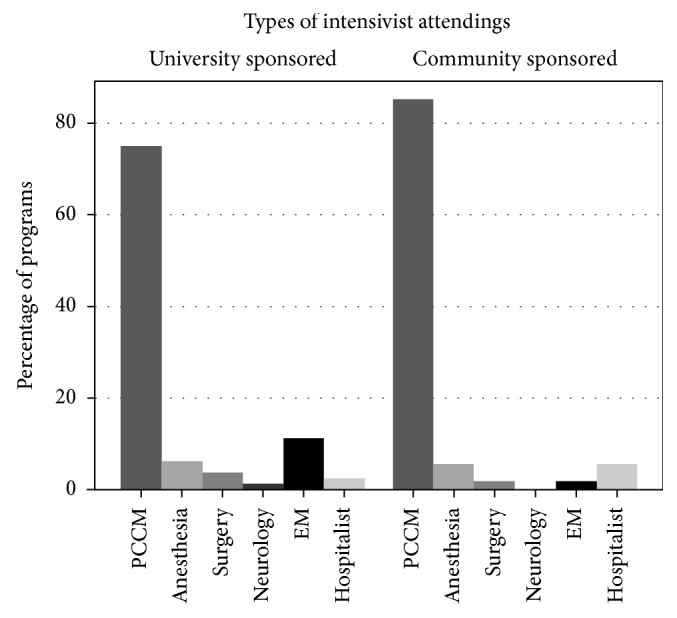
Bar graphs showing the percentage of residency programs reporting the presence of intensivists from different specialties on the ICU teaching service by residency sponsorship. In both groups, the most common intensivist specialty was PCCM, with the other base specialties variably represented in university- and community-sponsored programs. There was not a significant difference in the presence of non-PCCM attendings between the two types of residencies.